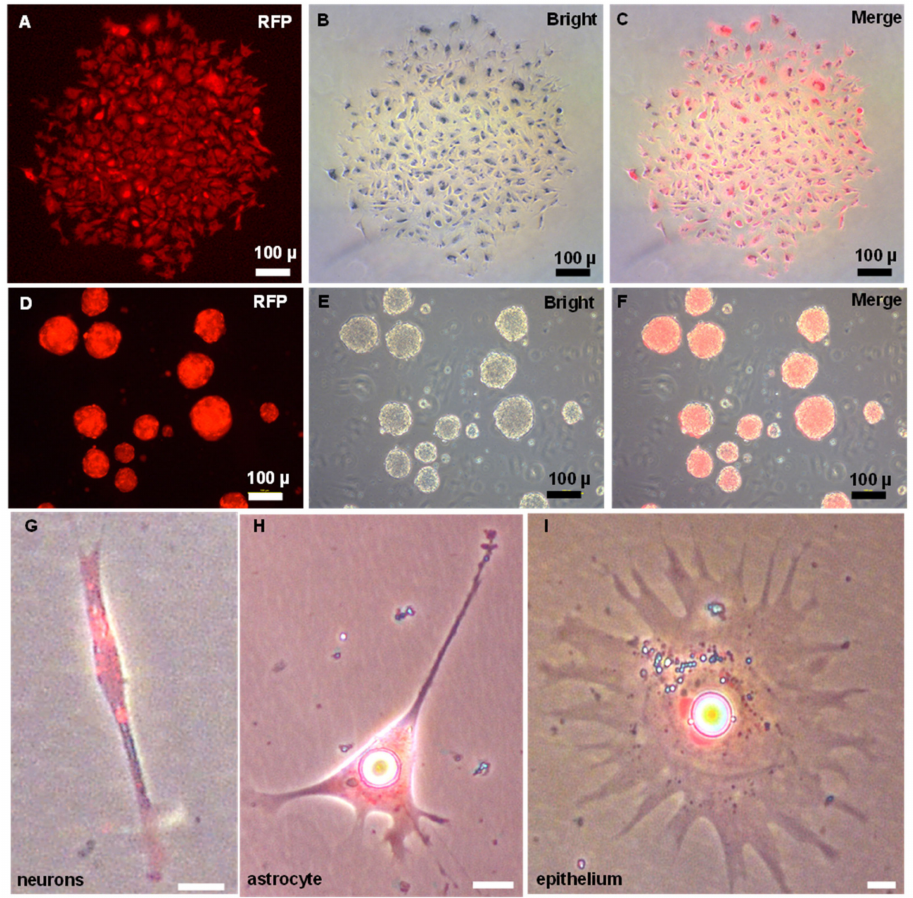
Figure 4. Pluripotency of ObSSCs in vitro. ( A – C ) Single colony of ObSSCs expressed with RFP by transfection with pCVpr at Passage 40. ( D – F ) Embryoid bodies formed by suspension culture of ObSSCs labeled with RFP. ( G – I ) The types of terminally differentiated cells from EBs. (Bars = 10 µ m unless